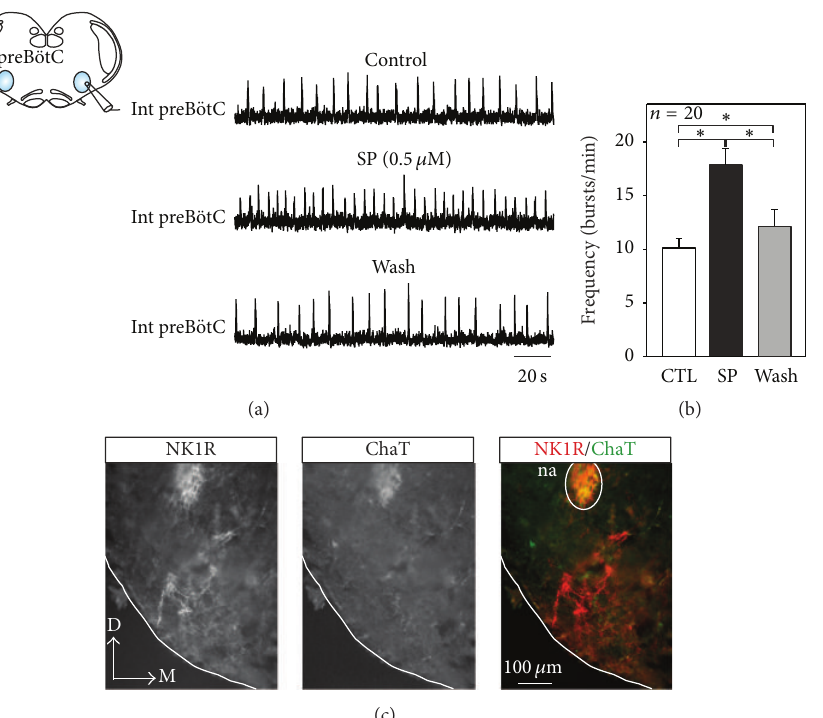
Figure 1: Substance P- (SP-) dependent modulation of the embryonic respiratory rhythm. (a) Schematic of the embryonic transverse brainstem slice isolating the preB¨otC network with the position of an extracellular recording electrode indicated. Integrated network activity (Int preB¨otC) recorded in control conditions (top), in the presence of 0.5 𝜇 M SP (middle) and after 30 minutes’ wash-out (bottom). (b) Pooled data showing mean ( ± SEM) inspiratory burst frequency obtained from 20 embryonic slices in control conditions (CTL, white bar), after 15min exposure to 0.5 𝜇 M SP (black bar) and after wash-out (gray bar). SP significantly increased the frequency of the spontaneous preB¨otC network rhythm. This effect was also partially reversible. The asterisk indicates significant difference at 𝑃 < 0.05 . (c) Immunodetection of NK1R receptors (red staining) in the preB¨otC area located ventral to the nucleus ambiguus (na) that was positive to both NK1R (red) and ChaT (green). D: dorsal, M: medial, and na: nucleus ambiguus.